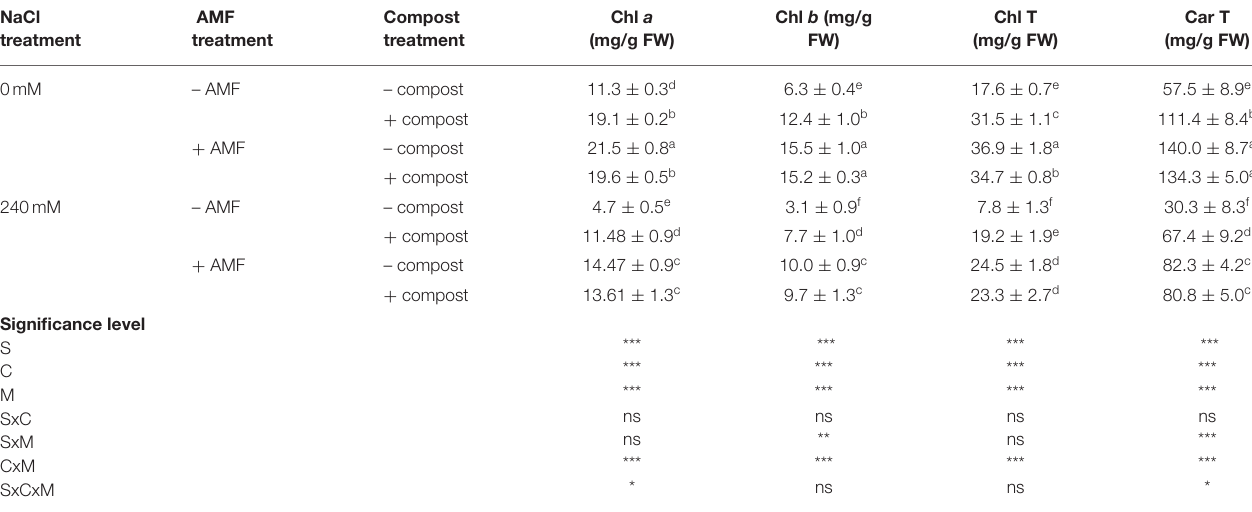
TABLE 4 | Photosynthetic pigment content of date palm plants under saline and non-saline conditions after application of compost and AMF alone or in combination. NaCl treatment